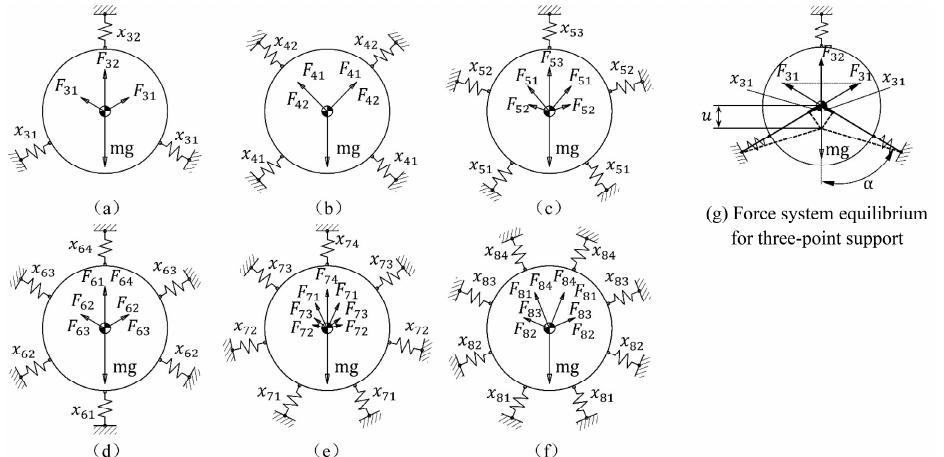
Figure 3. Support point configurations and the force systems for the multi-point support mode, under gravity along the radial direction. Mirror gravity is denoted by mg. K Ri , x ij , and F ij are spring stiffness, spring deflection, and corresponding spring force, respectively, for the support mode whose support point number is equal to 𝑖(𝑖 = 3,4,5,6,7,8) .